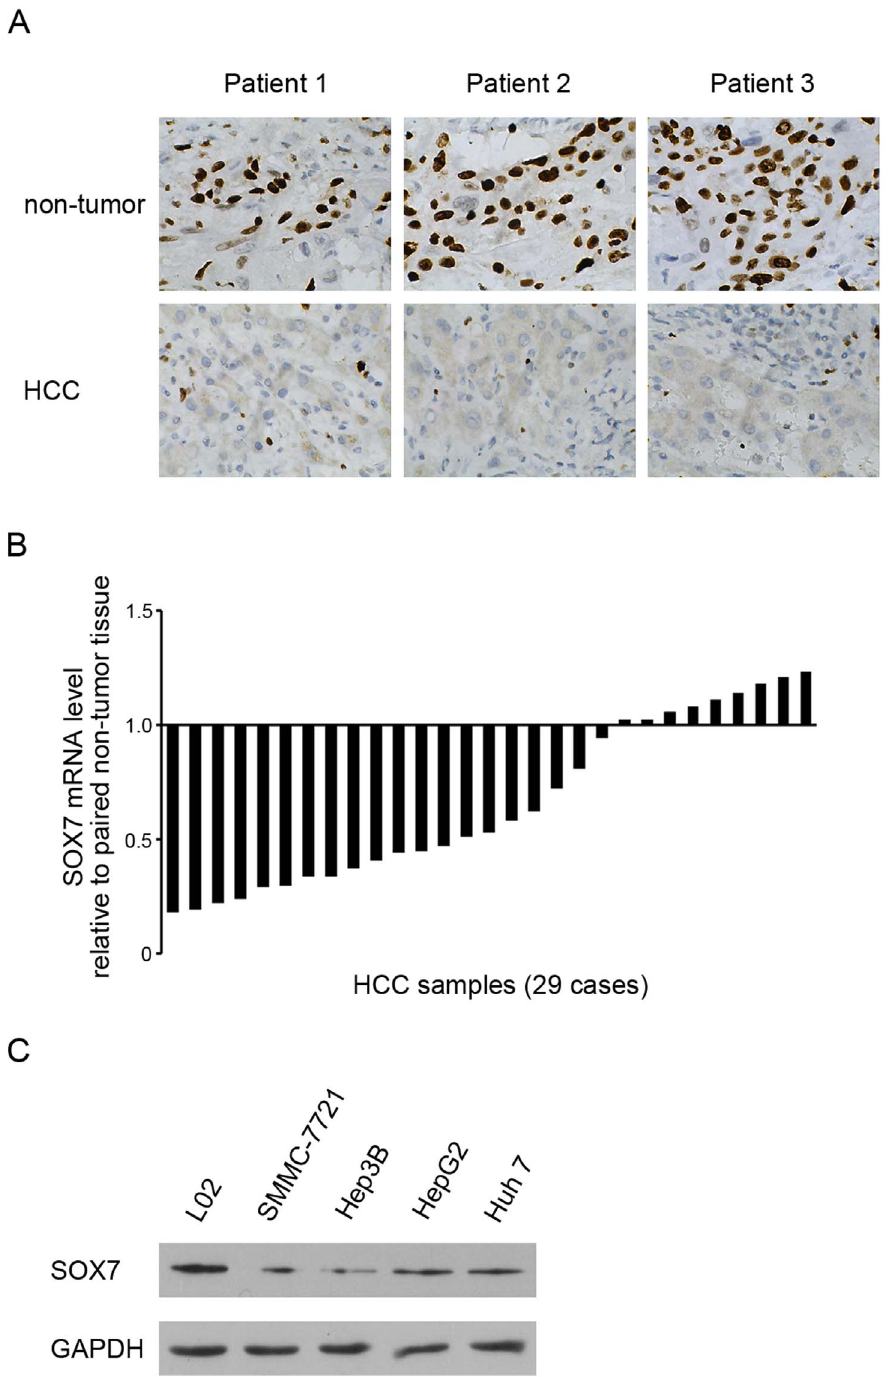
Figure 1. SOX7 was down-regulated in HCC tissues and in HCC cell lines. (A) Immunohistochemistry analysis of SOX7 expression in HCC and adjacent non-tumor liver samples. Representative photographs from three patients. (B) RT-PCR analysis of SOX7 mRNA expression in paired HCC samples. (C) Western Blotting analysis of SOX7 expression in HCC cell lines (SMMC-7721, Hep3B, HepG2 and Huh 7) and normal hepatocyte cell line (L02). GAPDH expression levels were used as internal controls. * indicates p , 0.05. The experiments were performed independently three times at least.